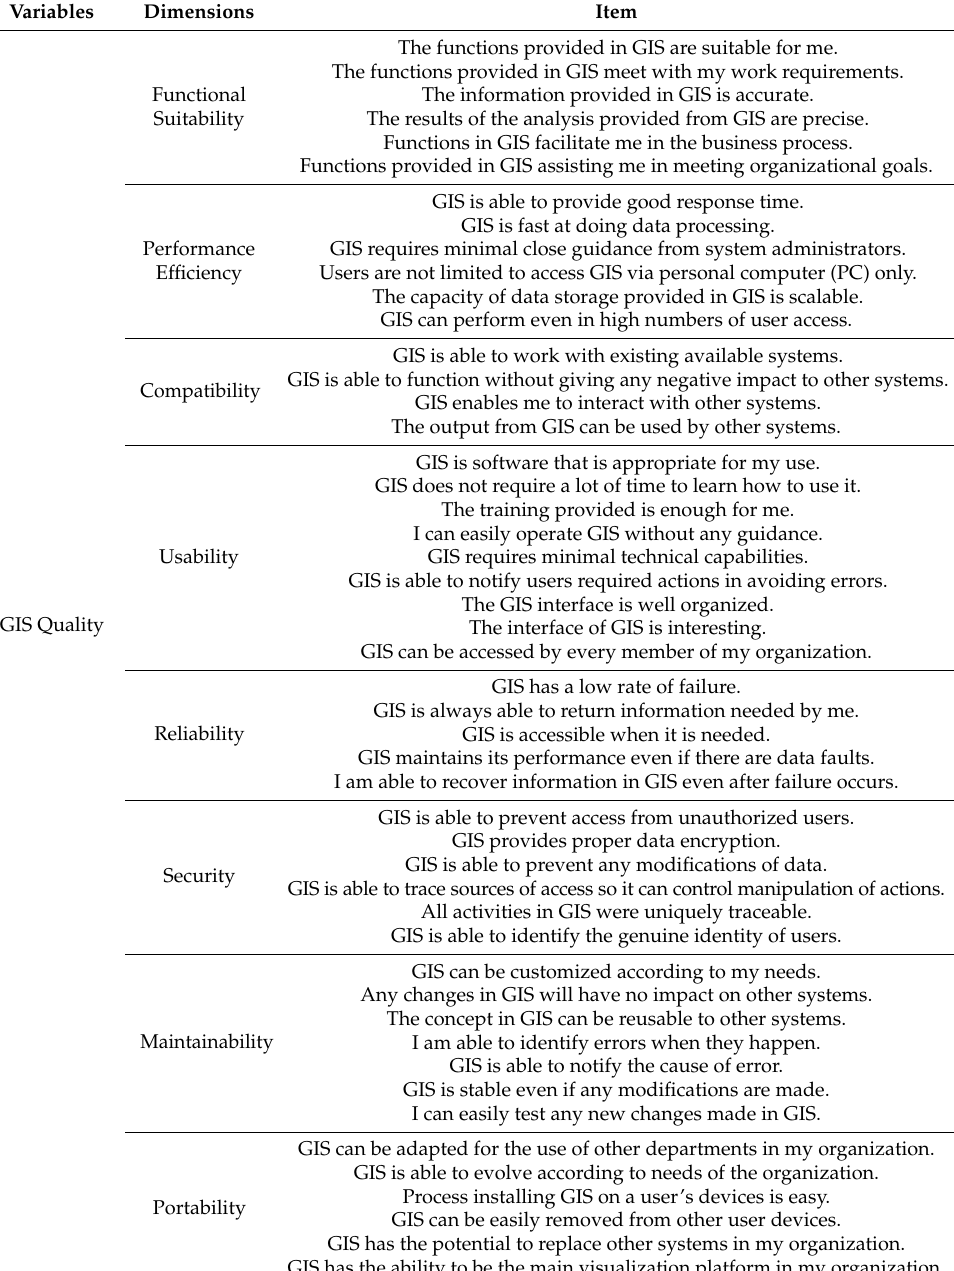
Table 1 lists the items for each dimension. Table 1. Items for each